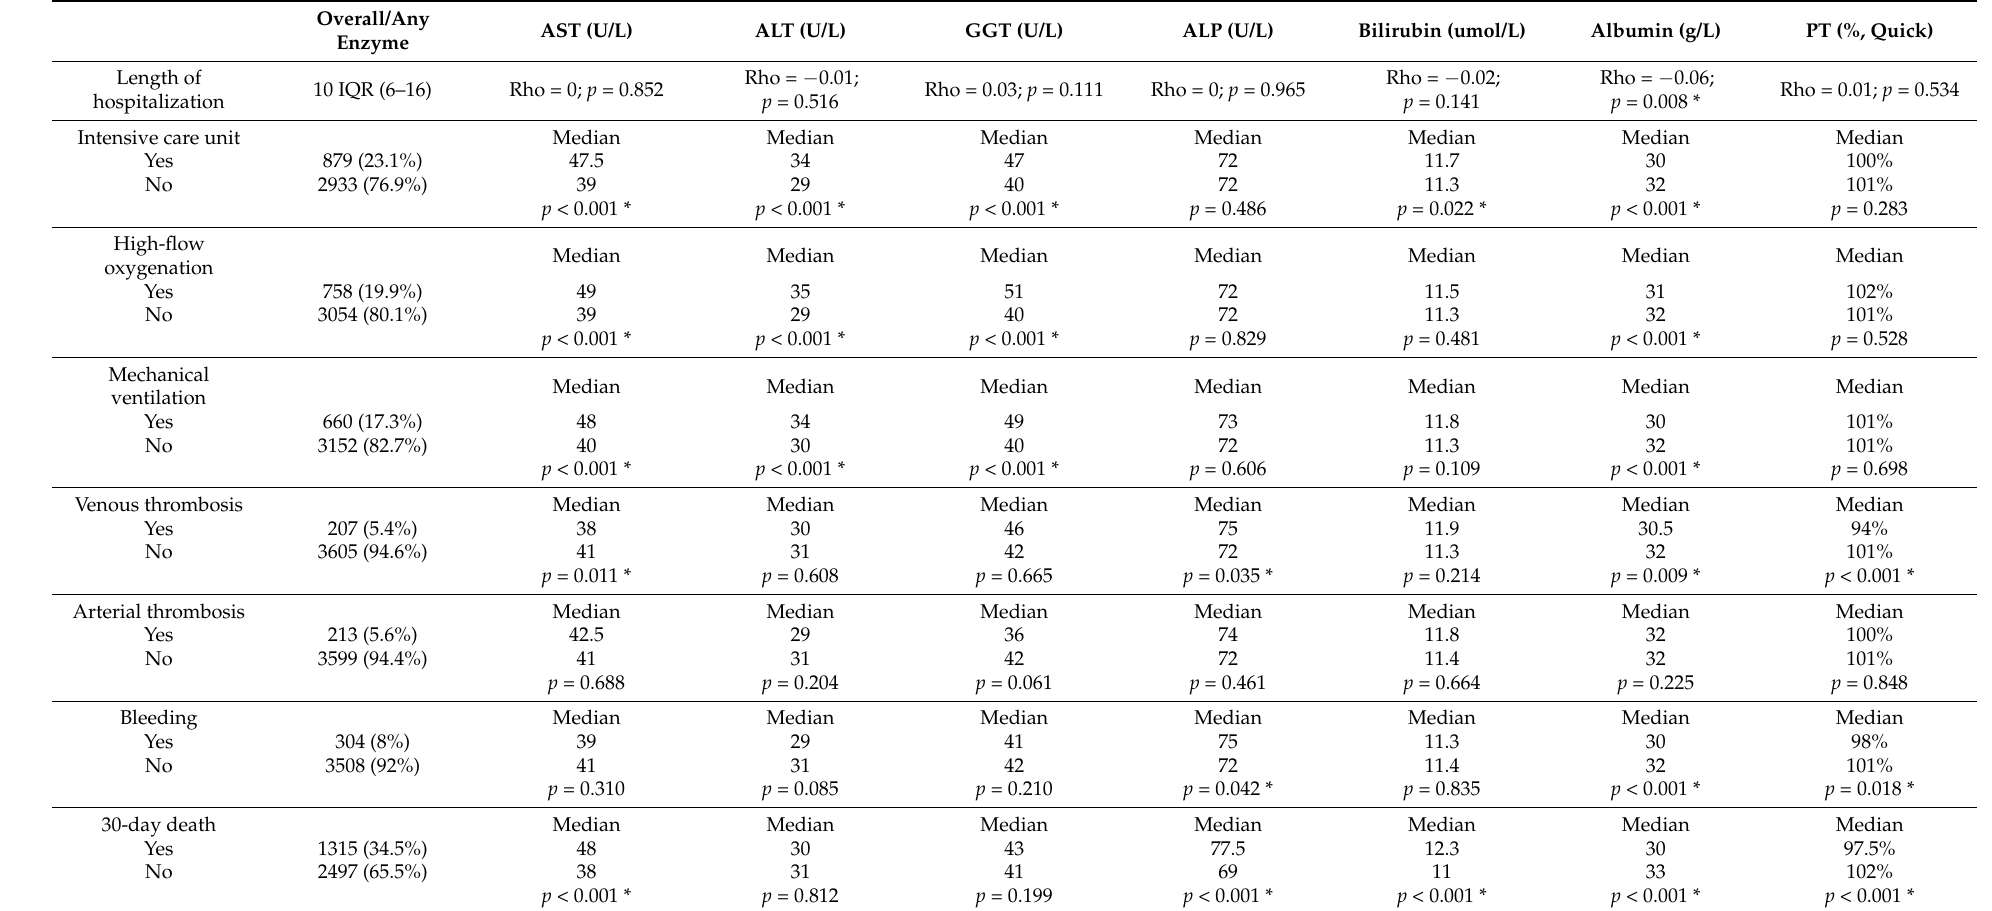
Table 2. Relationship of liver blood tests with the clinical outcomes of hospitalized patients with